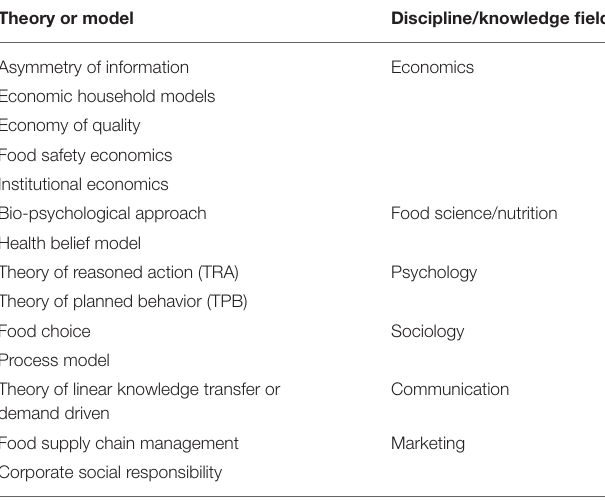
TABLE 1 | Theories, models, and disciplines for food consumer